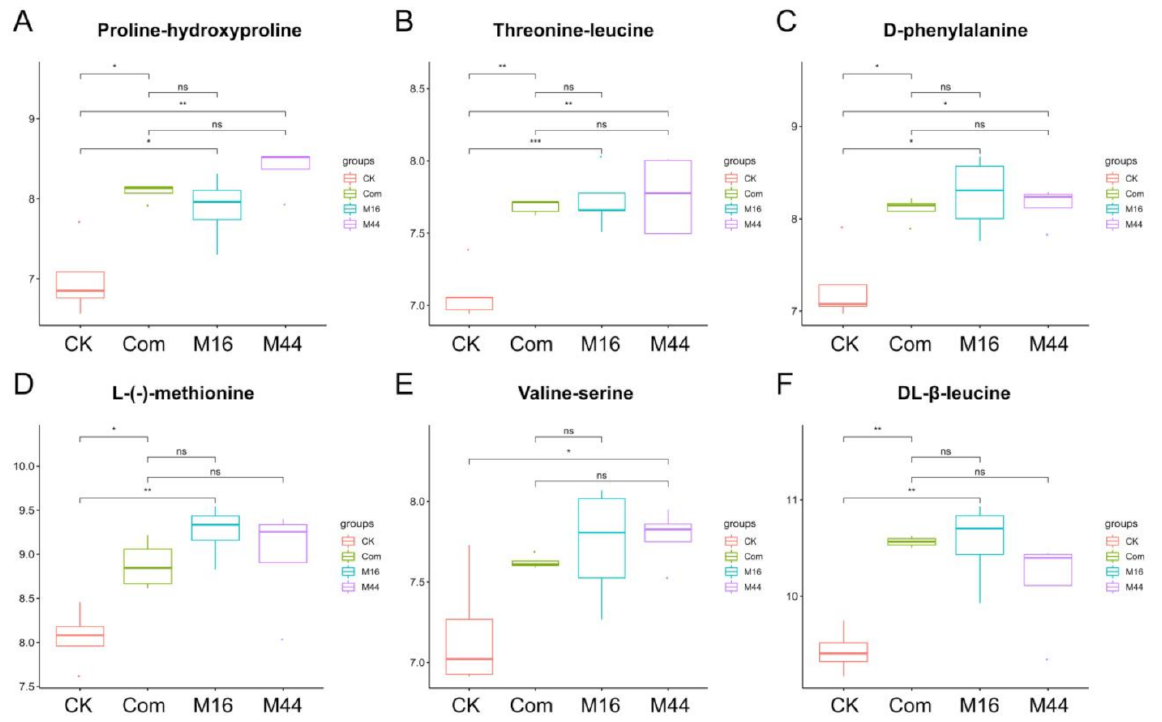
Figure 4. Boxplots of differential amino acids, proline-hydroxyproline ( A ), threonine-leucine ( B ), D-phenylalanine ( C ), L-(-)-methionine ( D ), valine-serine ( E ), and DL- β -leucine ( F ), based on a t -test. CK: control; M16: M16 treatment; M44: M44 treatment; Com: combination of M16 and M44. Asterisks between different treatments represent significance (* means 0.01 < p < 0.05; ** means 0.001 < p < 0.01; *** means p < 0.001).